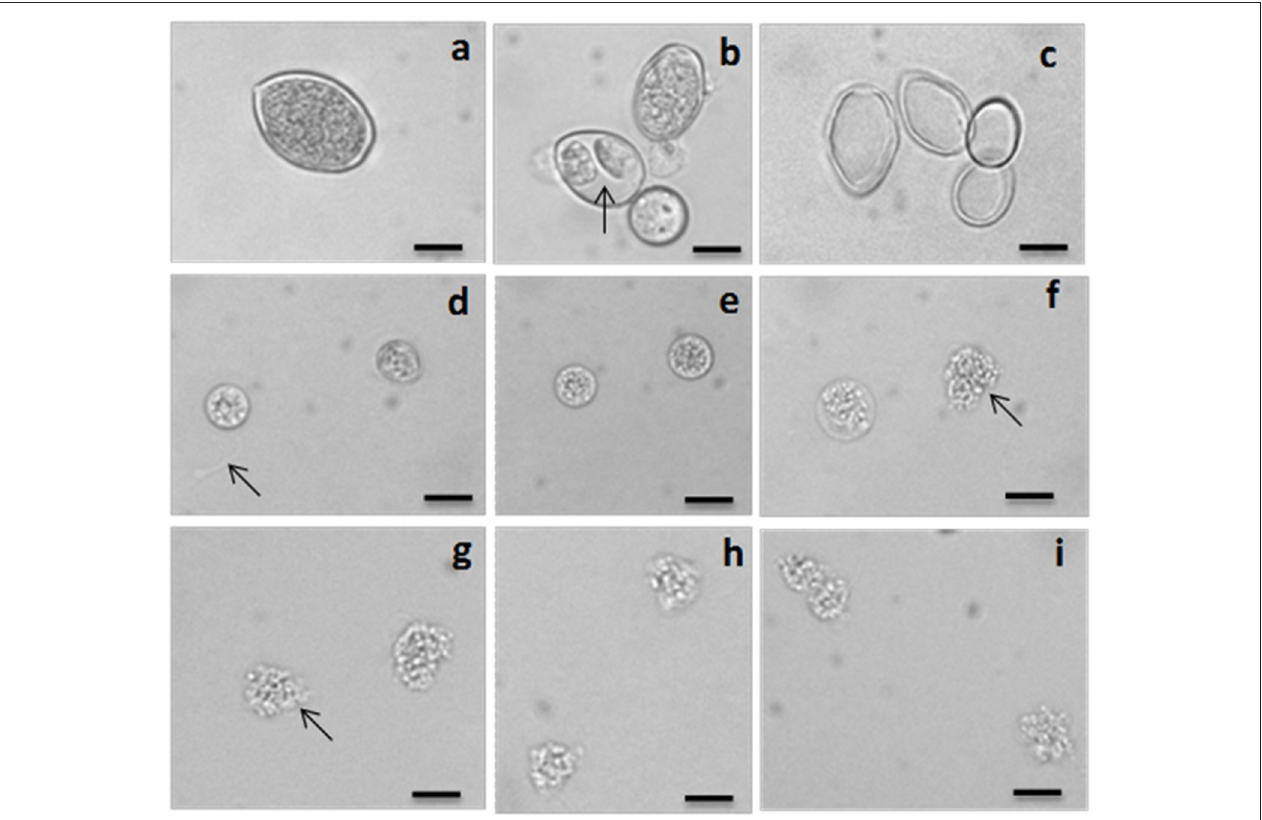
FIGURE 2 | Light micrographs showing sporangium, differentiating sporangium, empty sporangium (ghost) and inhibitory effects of dinactin, trinactin and gramicidin on zoospores of the grapevine downy mildew pathogen Plasmopara viticola . (a) A mature freshly harvested sporangium, (b) differentiated sporangia with developed zoospores (arrow) inside, (c) empty sporangia (ghosts) after release of zoospores, (d) two halted zoospores at the bottom of the dish just after addition of dinactin (1 µ g/ml). Arrow indicates the trace of a halted zoospore, (e) both halted zoospores become round by 5 min after treatment with dinactin (1 µ g/ml), (f) disruption of membrane and granulation of cell organelle and lysis (arrow) of zoospores by dinactin 10min after treatment (1 µ g/ml), (g) lysis of zoospores by dinactin 15min after treatment (1 µ g/ml), (h) lysis of zoospores by trinactin 15min after treatment (1 µ g/ml), (i) lysis of zoospores by gramicidin 15min after treatment (1 µ g/ml). Bar represents 10 µ m.